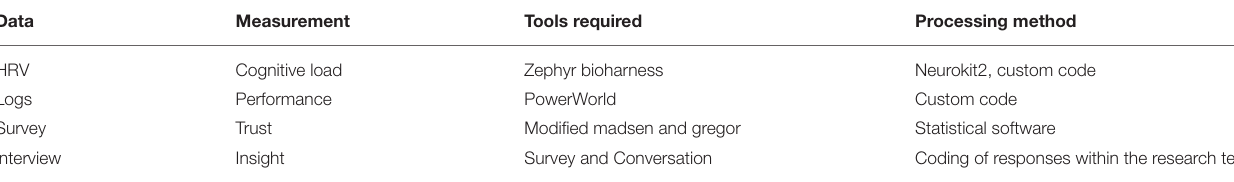
TABLE 1 | Overview of the data, measure, tools, and processing for each component of the